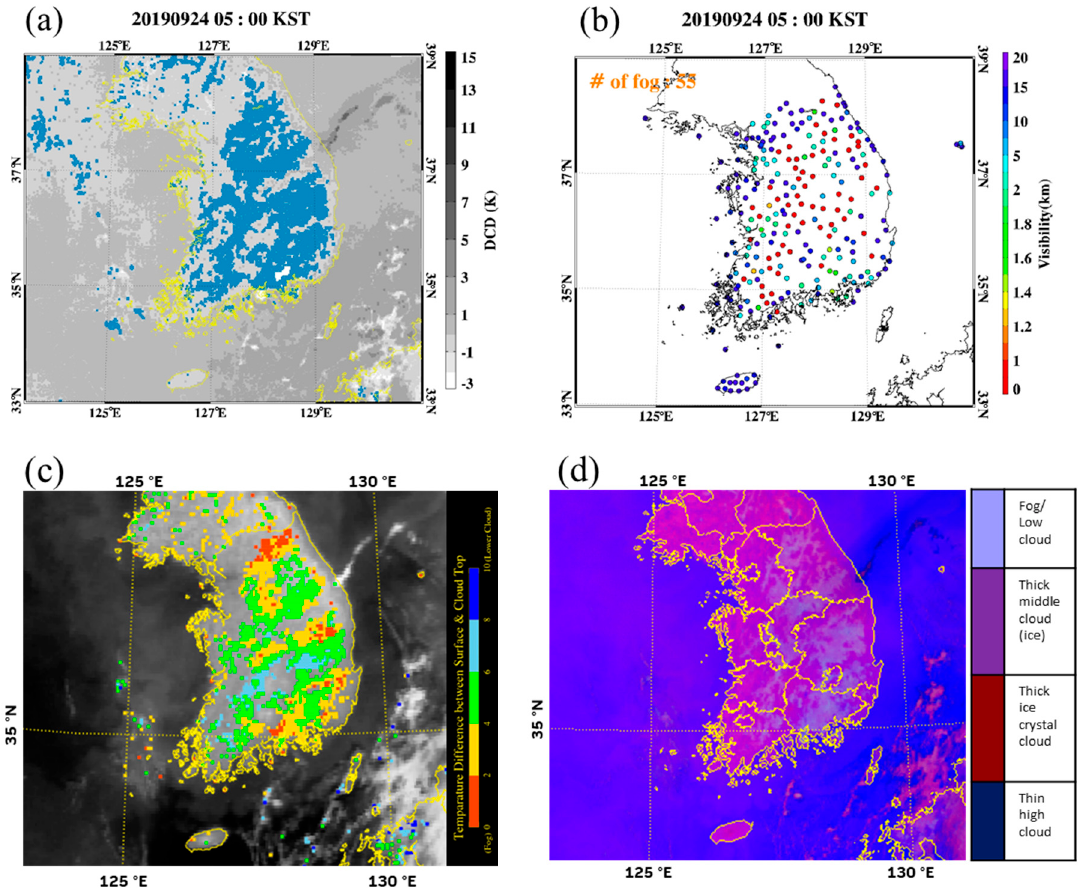
Figure 7. Sample image of fog detection results at 05:00 KST (South Korea Standard Time) 24 September 2019. ( a ) Fog image of GK2A_FDA, ( b ) ground-observed visibility, ( c ) fog image of CMDPS, and ( d ) fog product of GK2A RGB. Sky blue color in ( a ) indicates foggy pixels.